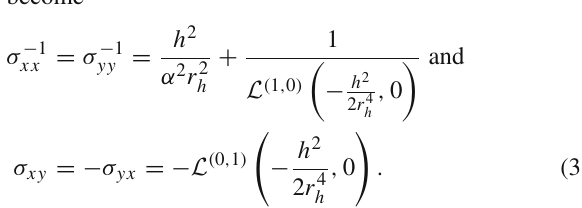
Fig. 1a, we plot the parameter space for a metal and an insulator with respect to h /ρ and θ . Note that, if θ (cid:10)= 0,